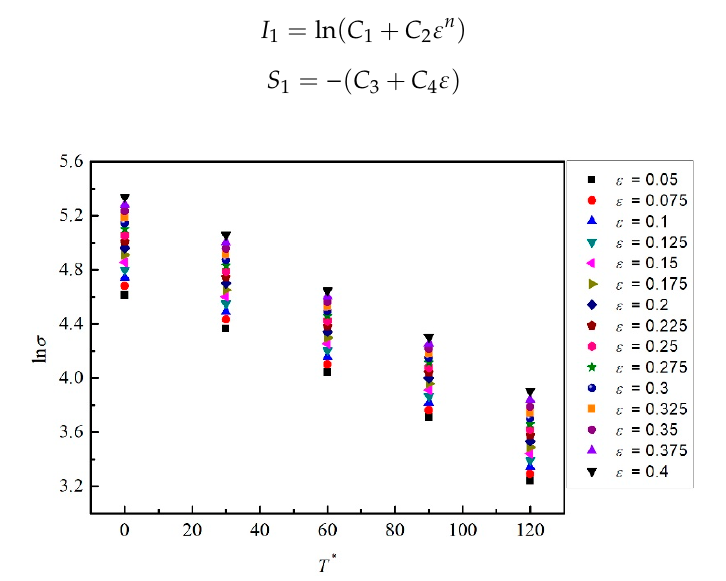
Figure 7. The relations between ln σ and T * for 15 different strains.